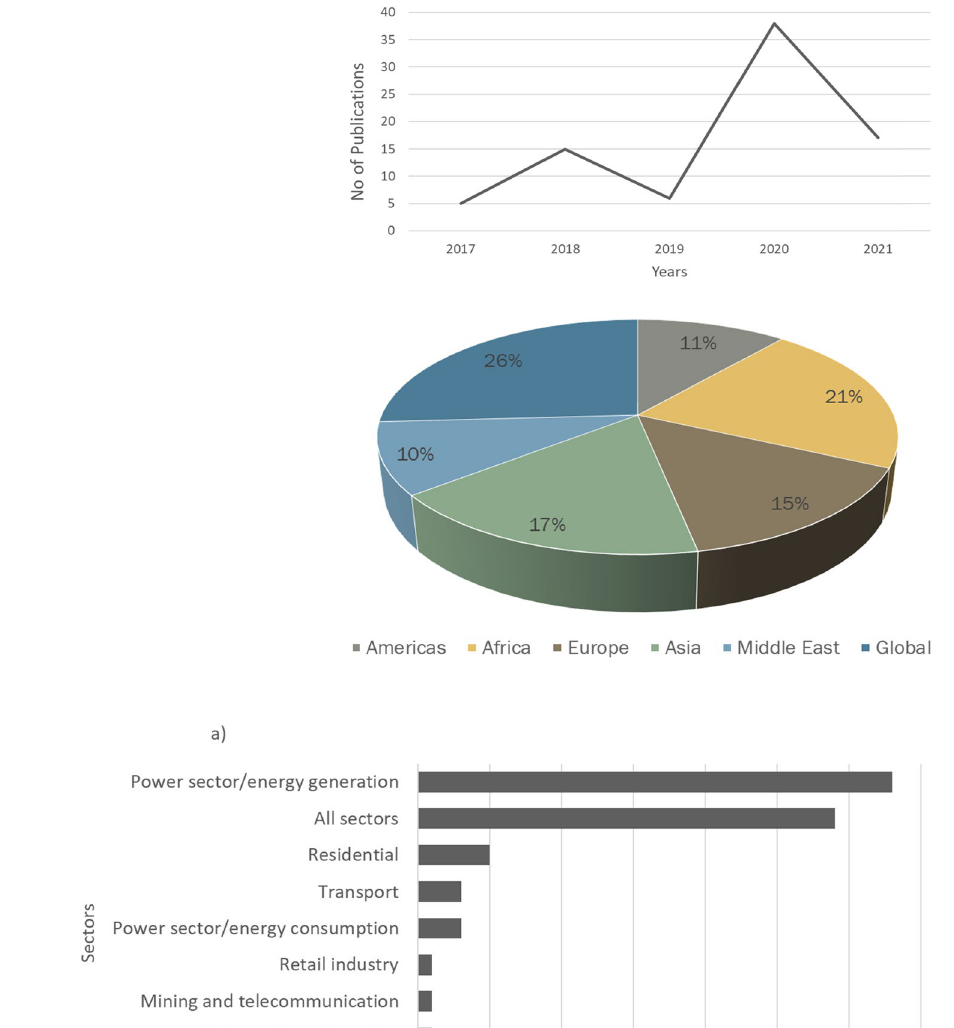
Fig. 3 Trend of publications. Source: Authors